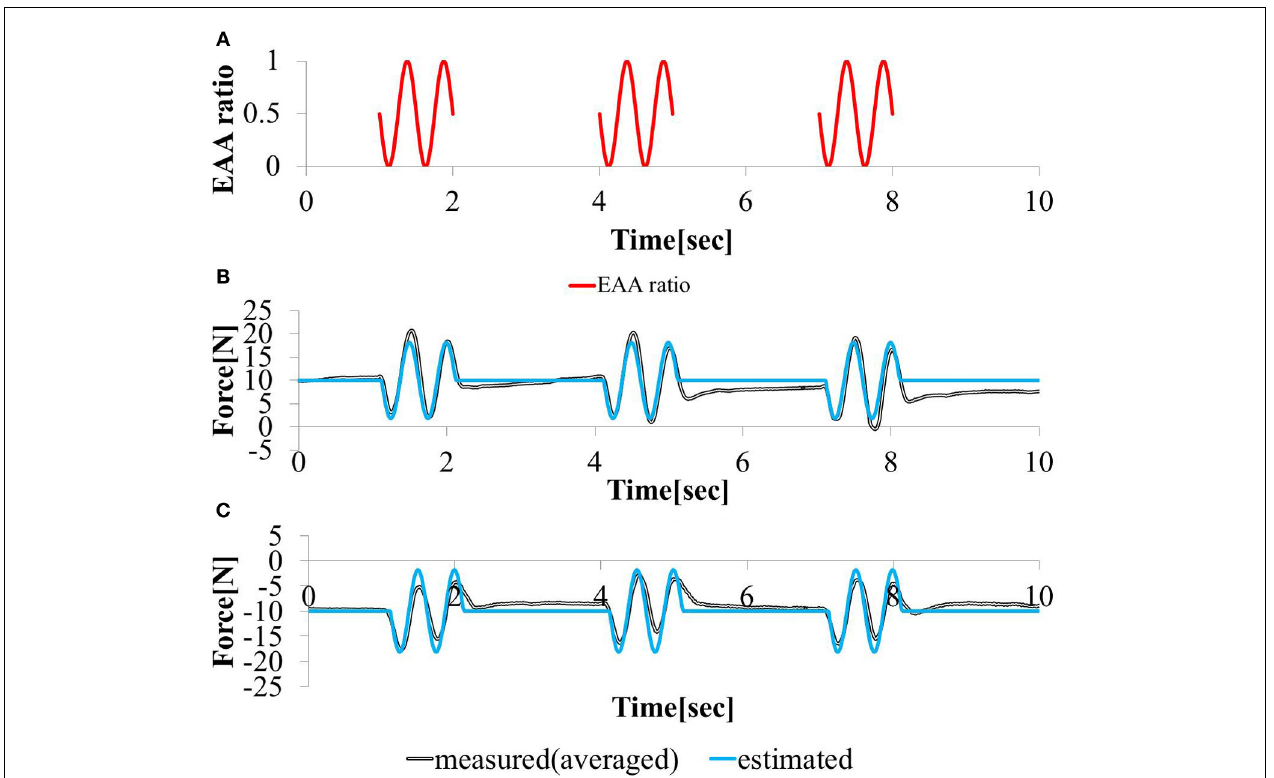
FIGURE 10 | Responses to sinusoidal (A) EAA ratio in (B) positive (C) negative 10 (N) force exertion